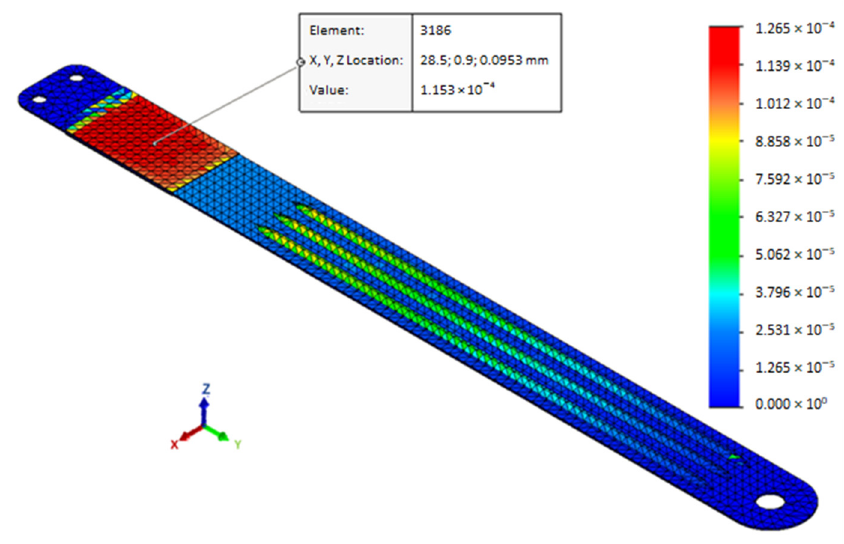
Figure 10. Z-axis normal strain corresponding to maximal imposed displacement. The measurement unit is mm/mm.